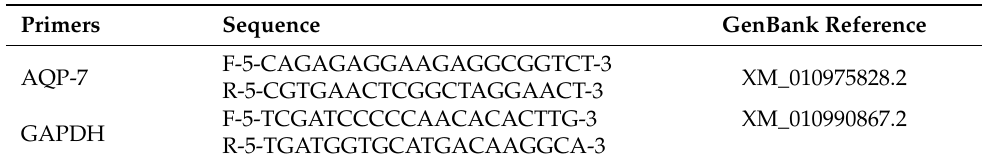
Table 2. Real-time qPCR primer sequences targeting gene expression of